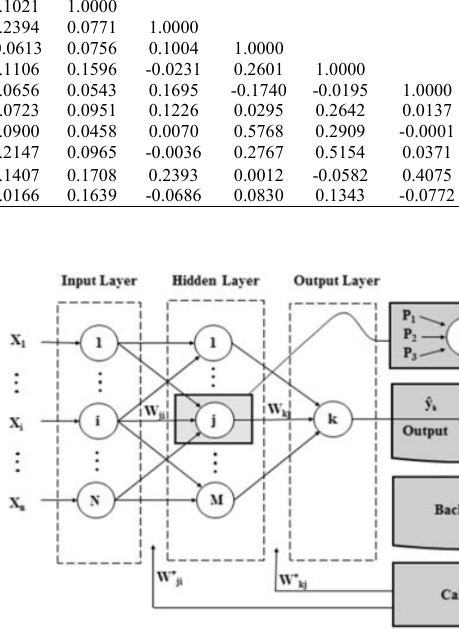
Fig. 2: Typical structure of three-layered FFNN (Nourani et al., 2012)